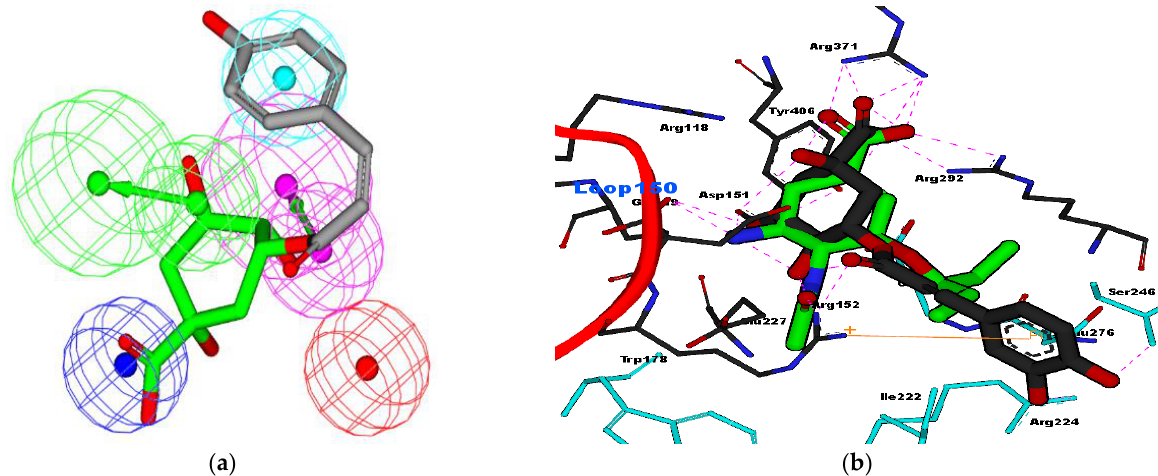
Figure 4. ( a ) CGA fit with oseltamivir pharmacophore features and ( b ) interaction of CGA with NA (PDB ID: 2HU4), compared to oseltamivir (green)-NA. Blue color residues were shown for hydrophobic interaction, while pink dotted lines show hydrogen bond interaction between residues of NA with the ligands. Orange line for cation– pi interaction between the aromatic ring of CGA and Arg152 of NA.